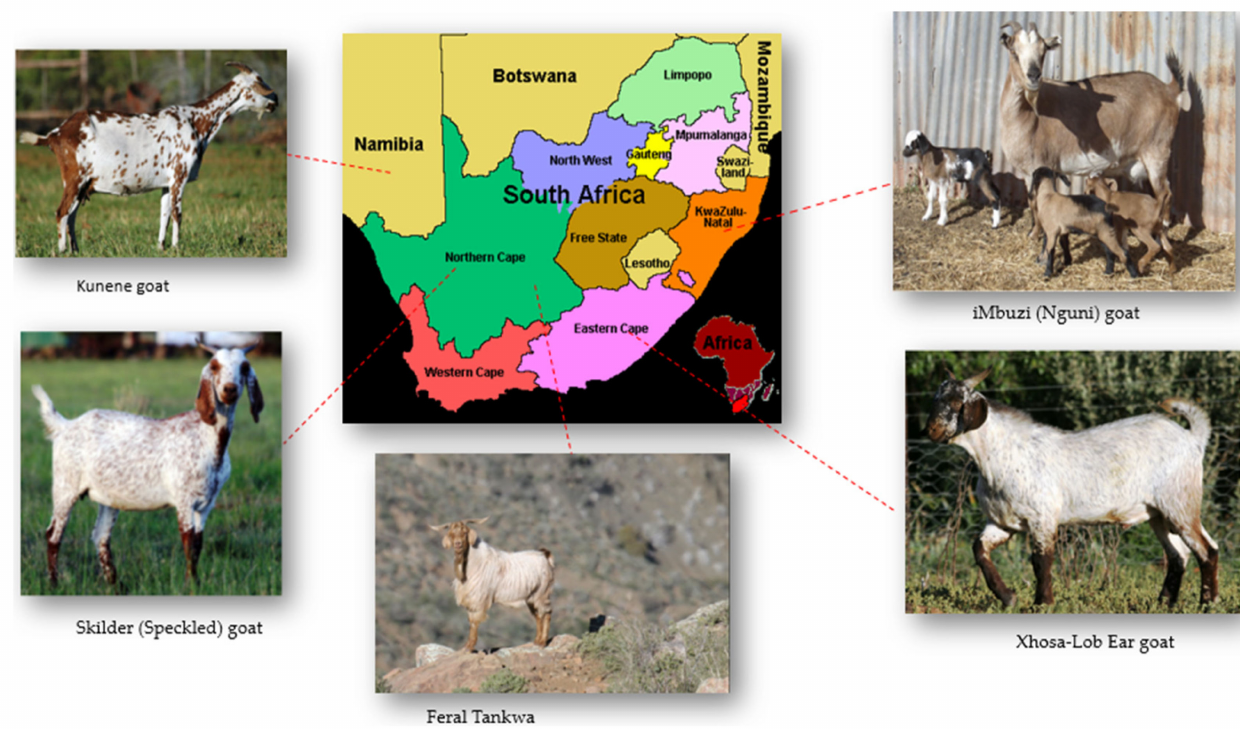
Figure 1. Established Indigenous veld goat ecotypes of Southern Africa and places of origin. South African communal farming is disadvantaged by herds with fewer animals and a low flock density per population [11]. In most instances, the mating is